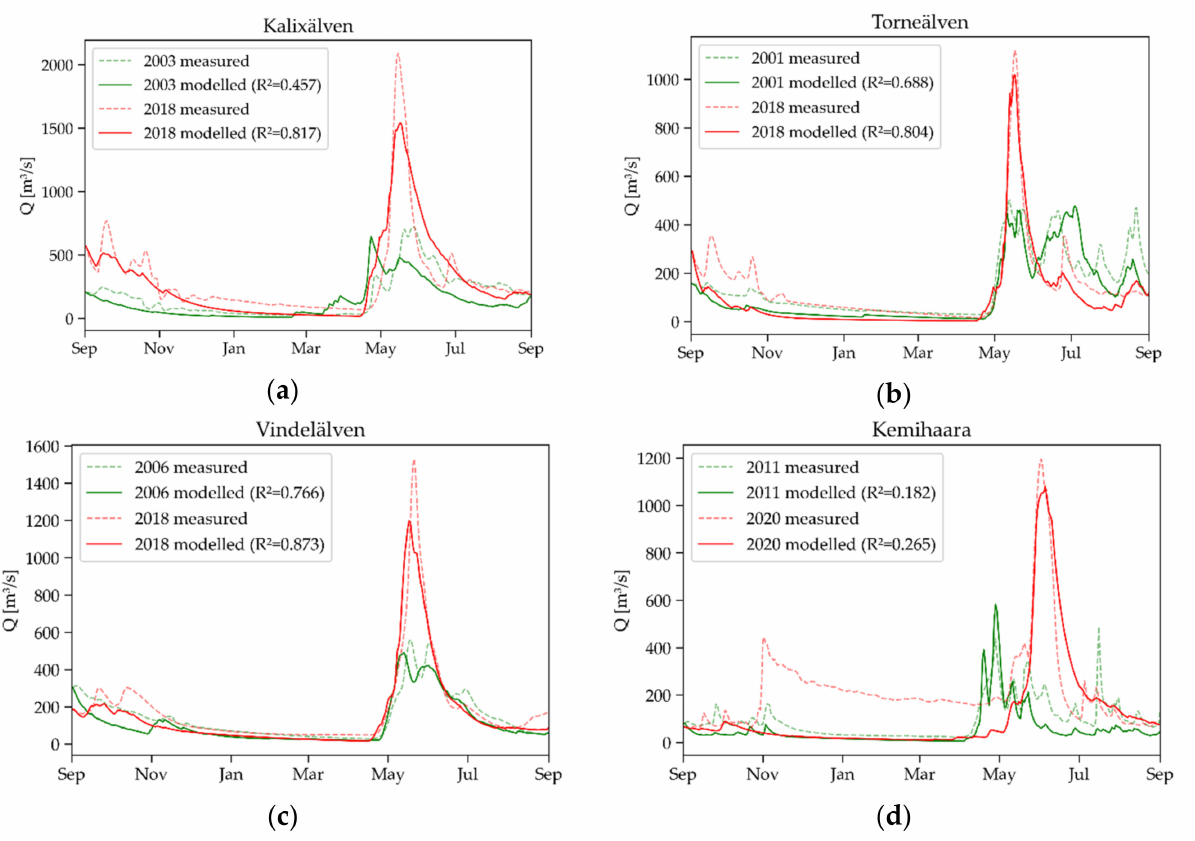
Figure 16. SRM results for the maximum and minimum peak discharge of ( a ) Kalixälven, ( b ) Torneälven, ( c ) Vindelälven and ( d )